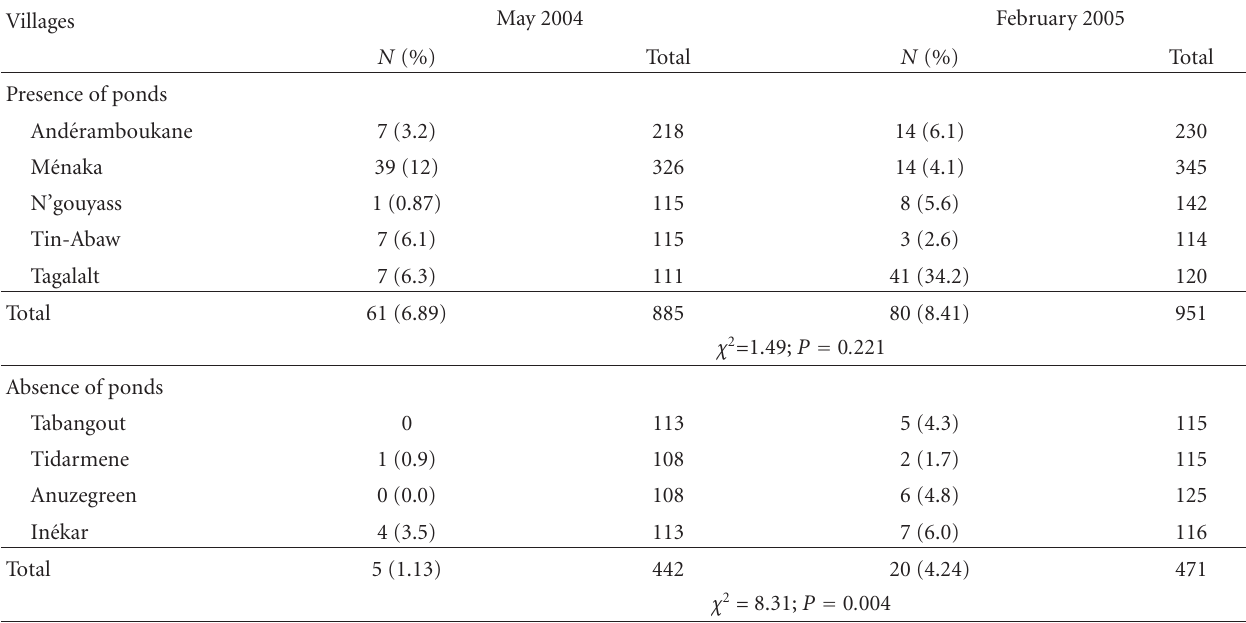
Table 5: Infection prevalence of malaria by site with the presence of pounds and